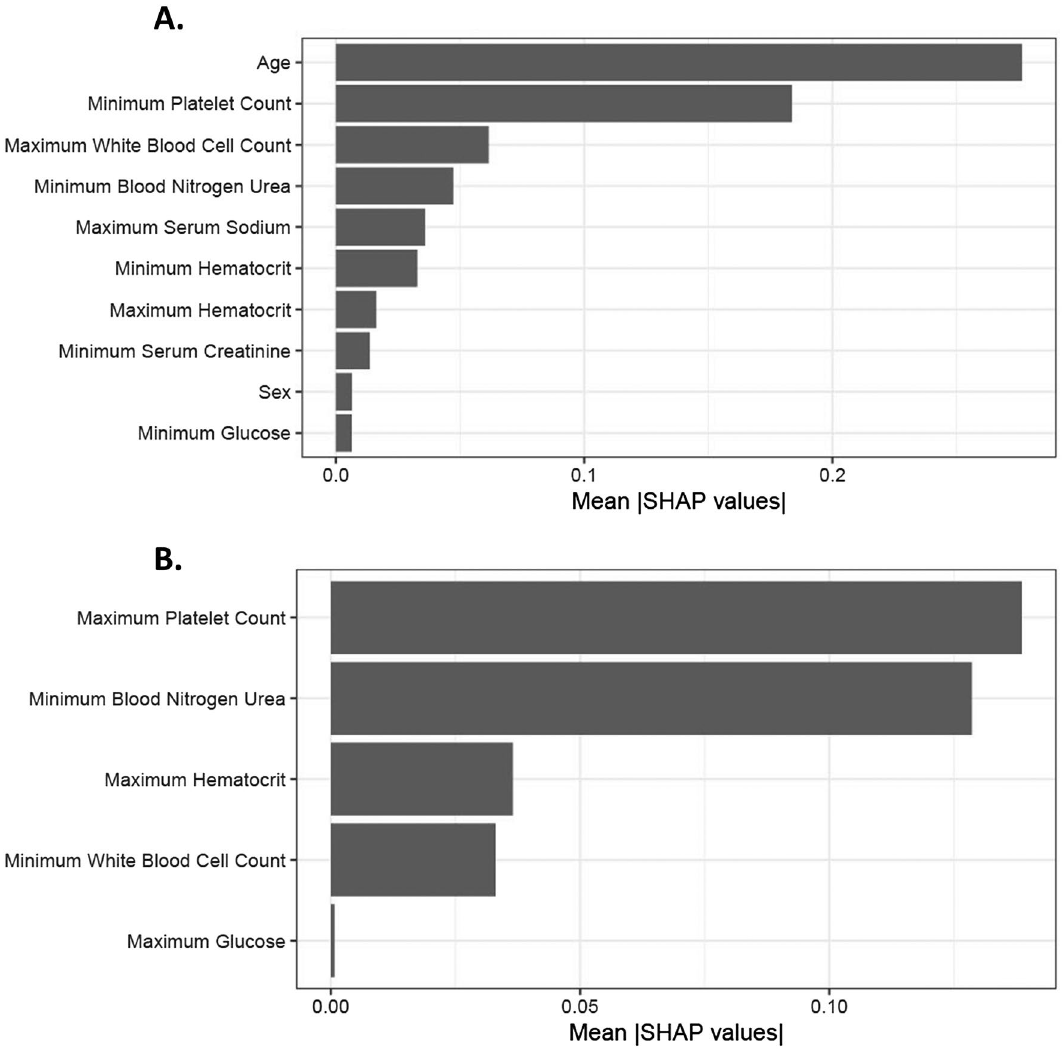
Figure 2. Variable importance plots for mortality in all patients and in patients over 50 years of age. ( A ) Top predictor variables for mortality in all patients. Mean SHAP values are provided on the x-axis, which shows that age, minimum platelet count, maximum white blood cell count, minimum blood urea nitrogen, maximum serum sodium, minimum haematocrit, maximum hematocrit, minimum serum creatinine, sex and minimum glucose are the top-10 variables. ( B ) Top predictor variables for mortality in patients over 50 years of age. Mean SHAP values are provided on the x-axis for the mortality prediction model in patients over 50 years of age, which includes the five selected variables: maximum platelet count, minimum blood urea nitrogen, maximum hematocrit, minimum white blood cell count, and maximum